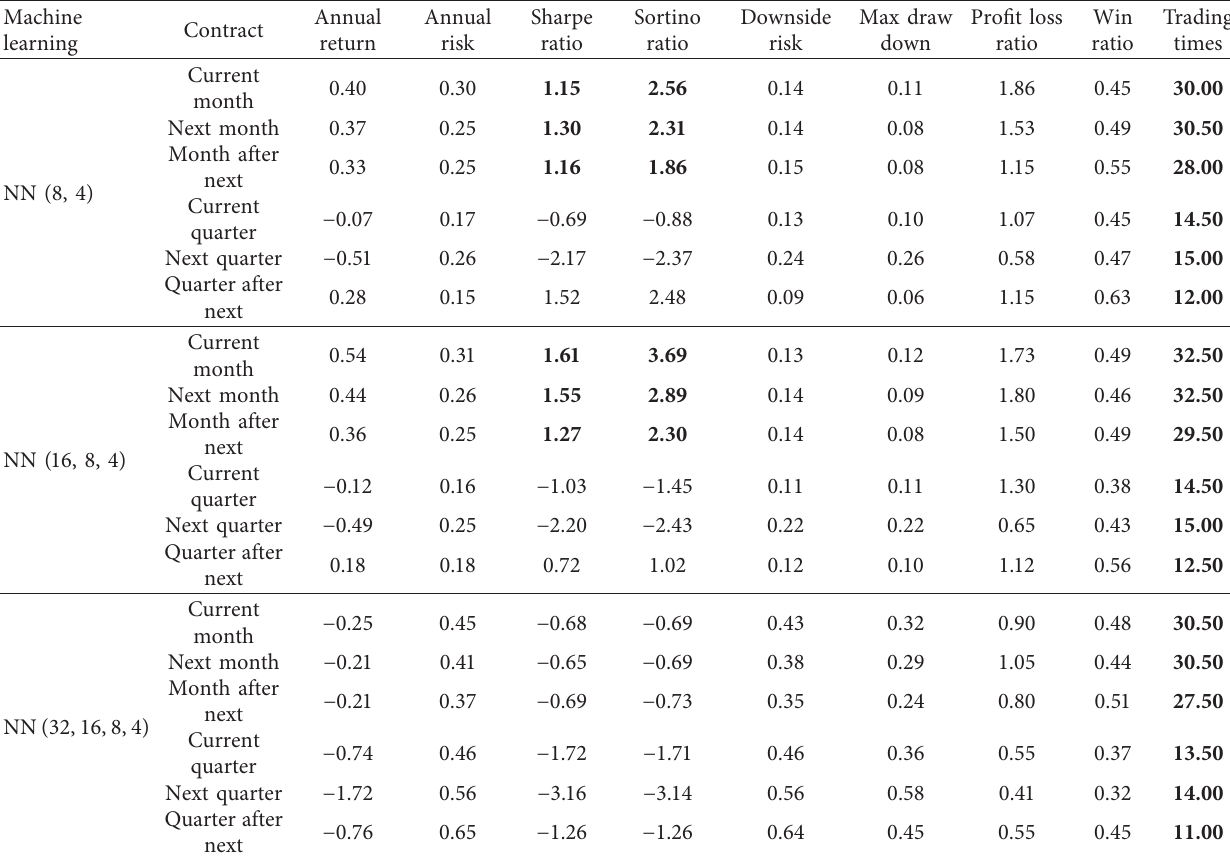
Table 8: Option strategy of predicting the rise and fall of volatility by threshold (use 12 features M2, threshold � 0.3). Machine learning